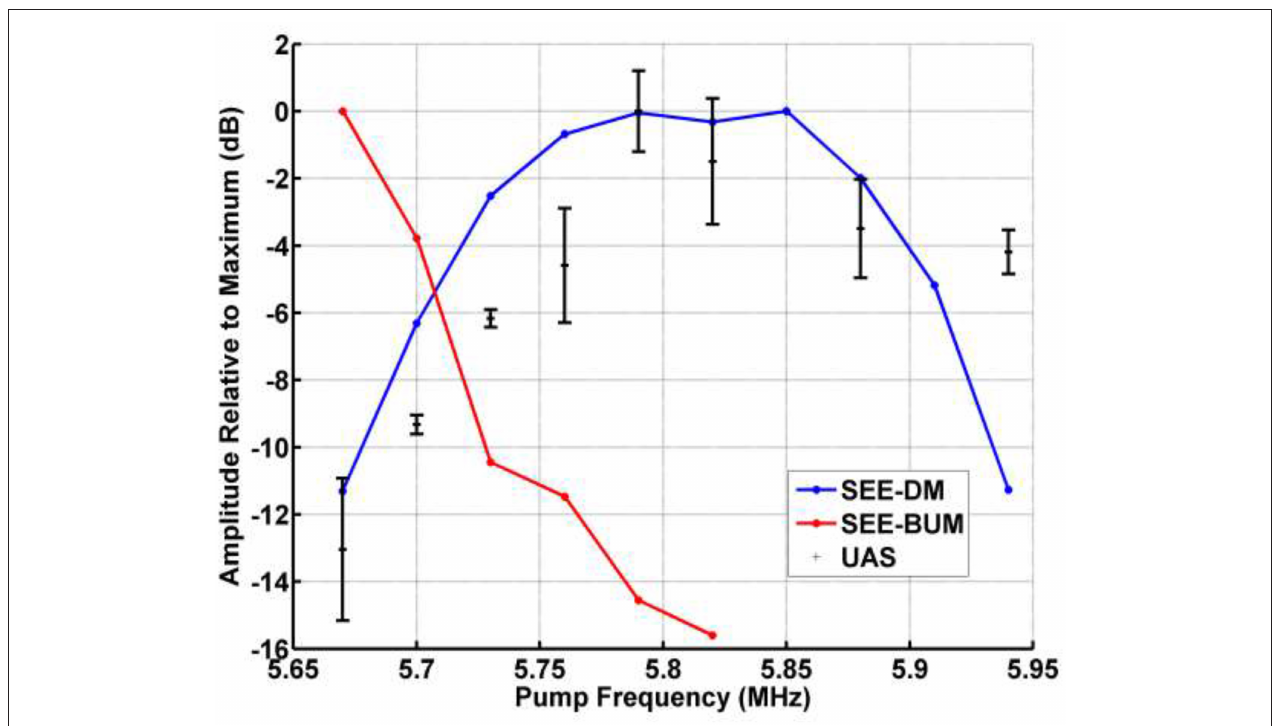
FIGURE 6 | Amplitudes of DM, BUM, and the intensity of the HF signals received at UAS (points with bars) vs. the pump frequency. The amplitudes are given in dB normalized by the peak values. All data points are time averages. Error bars of the HF signals trace are the standard deviation of the mean of SNR measured at UAS [adapted from ( Najmi et al.,